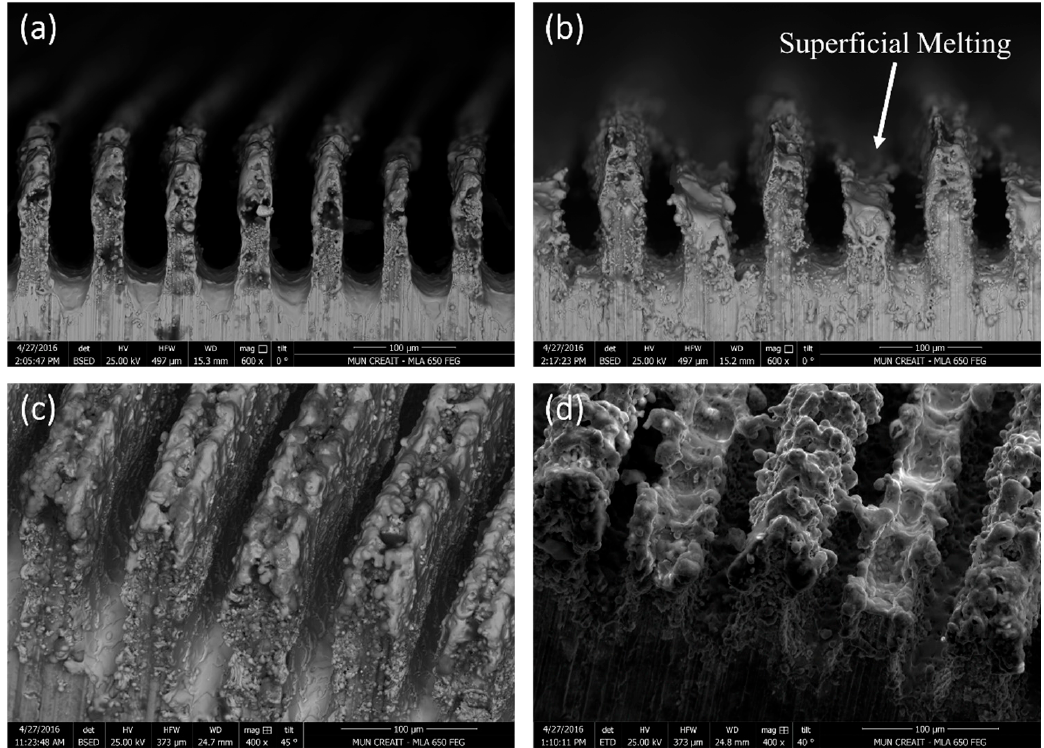
Figure 2. SEM images of ( a ) the channeled structure side view; ( b ) the varied channeled structure side view; ( c ) the channeled structure top view and ( d ) the varied channeled structure top view.